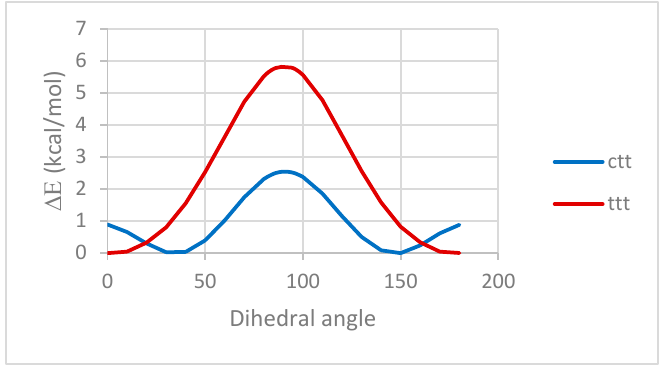
Figure A3. Ground state potential energy surface of the ctt and ttt conformers in which the dh1 dihedral angle (1-2-3-4, see Figure 1) is rotated from 0° to 180° while the rest of the backbone is kept constant (B3LYP/cc-pVDZ data). The trajectories of cct, ccc and ctc are identical to the one of ctt and are therefore not depicted by a color code.